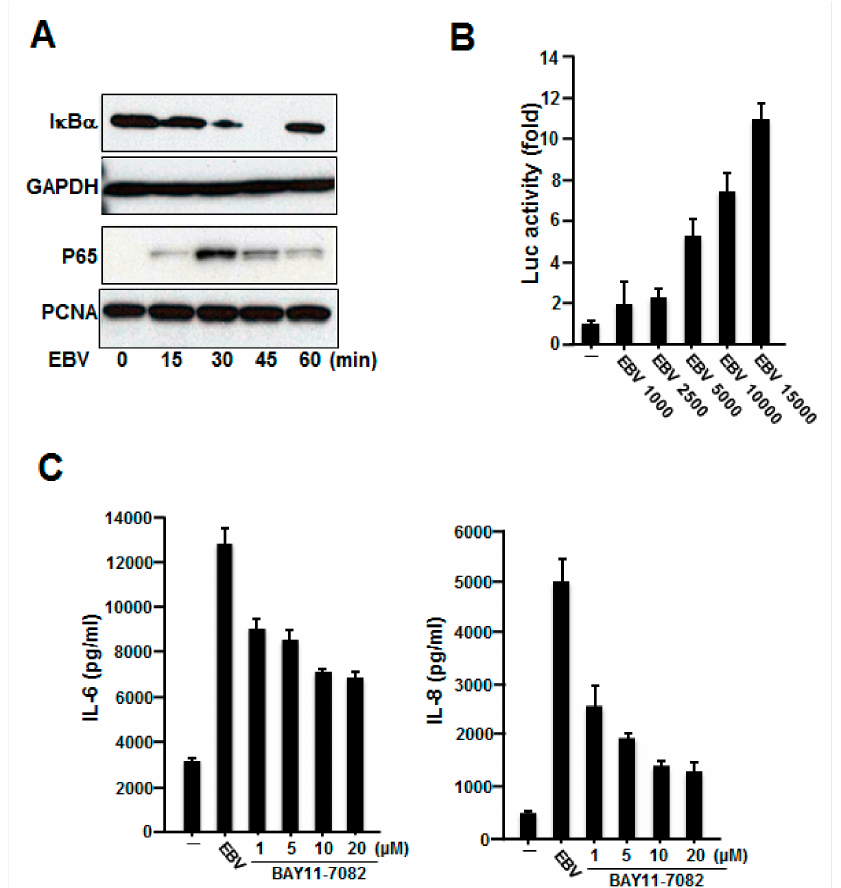
Figure 3. Activation of NF- κ B by EBV and its involvement in inactivated EBV-induced IL-6 and IL-8 production. ( A ) Inactivated EBV-induced degradation of I κ B α and translocation of p65 to the nucleus. HGFs were treated with inactivated EBV (5000 copies/mL) for the indicated time periods. Cytoplasmic extracts were fractionated using sodium dodecyl sulfate-polyacrylamide gel electrophoresis and immunoblotted with anti-I κ B α and GAPDH antibodies. Nuclear extracts were immunoblotted with anti-p65 and PCNA antibodies. ( B ) Activation of NF- κ B-dependent gene expression by inactivated EBV. The 4x κ B-luc reporter plasmid at 20 ng was transfected into HGFs, which were incubated for 24 h and stimulated with the indicated amount of inactivated EBV for an additional 8 h. The luciferase activity of each cell lysate was then measured. All experiments were performed in triplicate, and the data are presented as the fold increase in luciferase activity (mean ± standard deviation) relative to the control. ( C ) Effects of BAY11-7082 on inactivated EBV- induced IL-6 and IL-8 production. HGFs were pretreated with various concentrations of BAY11- 7082 for 1 h and then incubated with inactivated EBV (5000 copies/mL) for an additional 24 h. The cell culture supernatants were analyzed for IL-6 and IL-8 levels using ELISA. NF- κ B, nuclear factor kappa B; EBV, Epstein–Barr virus; IL, interleukin; HGFs, human gingival fibroblasts; ELISA, enzyme-linked immunosorbent assay; PCNA, proliferating cell nuclear